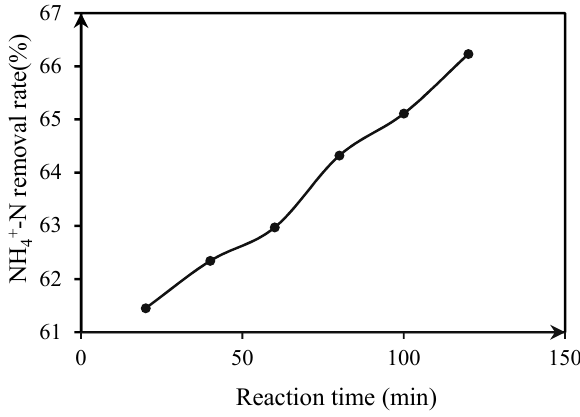
Figure 7. Under the dark reaction conditions.